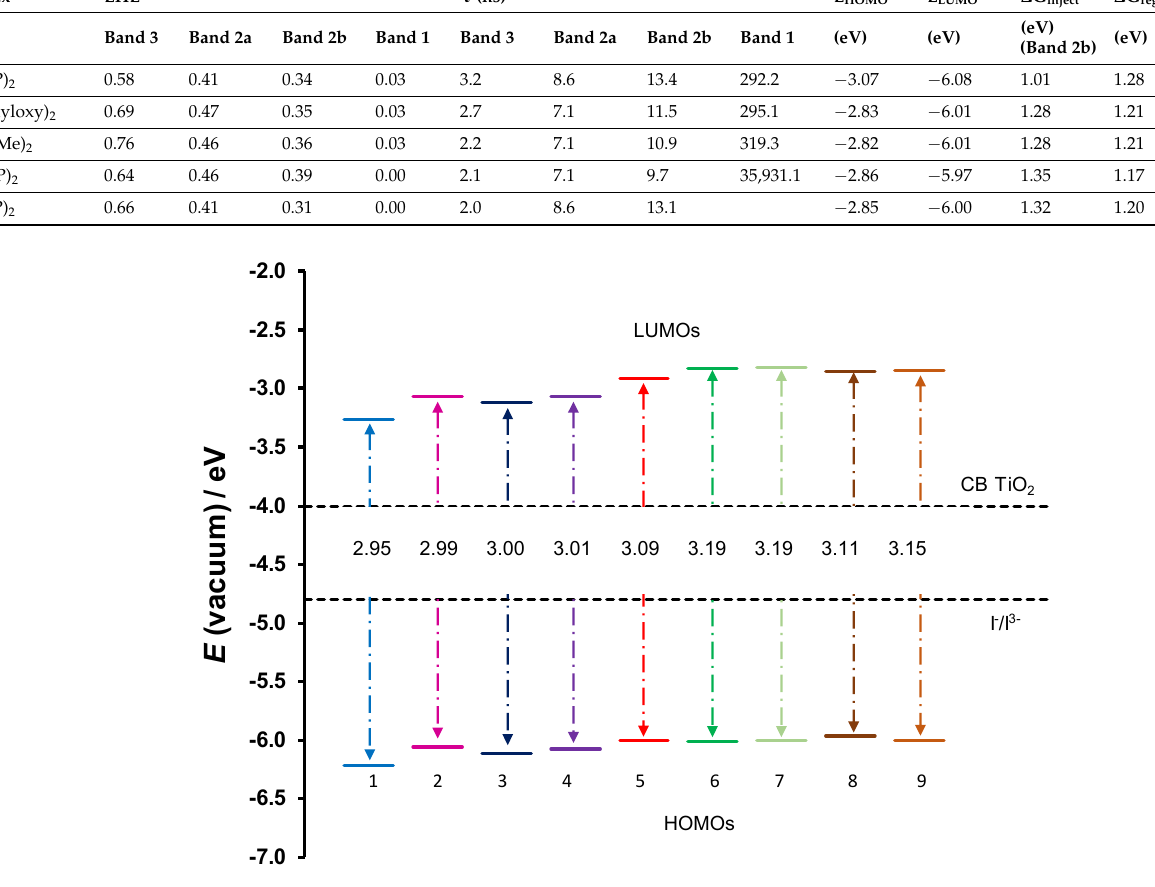
Figure 7. Energy levels and HOMO–LUMO gaps of the Cu(II) complexes calculated at the B3LYP/6- 311G(d,p)/def2-TZVPP level in DMSO solution, compared to the CB of TiO 2 ( − 4.0 eV) and the redox potential of the I − /I 3 − electrolyte ( − 4.8 eV). Table 3. B3LYP/6-311G(d,p)/def2-TZVPP calculated light harvesting efficiency (LHE), excited state lifetime ( τ ), E HOMO , E LUMO , Δ G inject and Δ G regenerate . Table 4. Published values of absorbance maximum wavelength ( λ max,calc ), oscillator strengths (f),